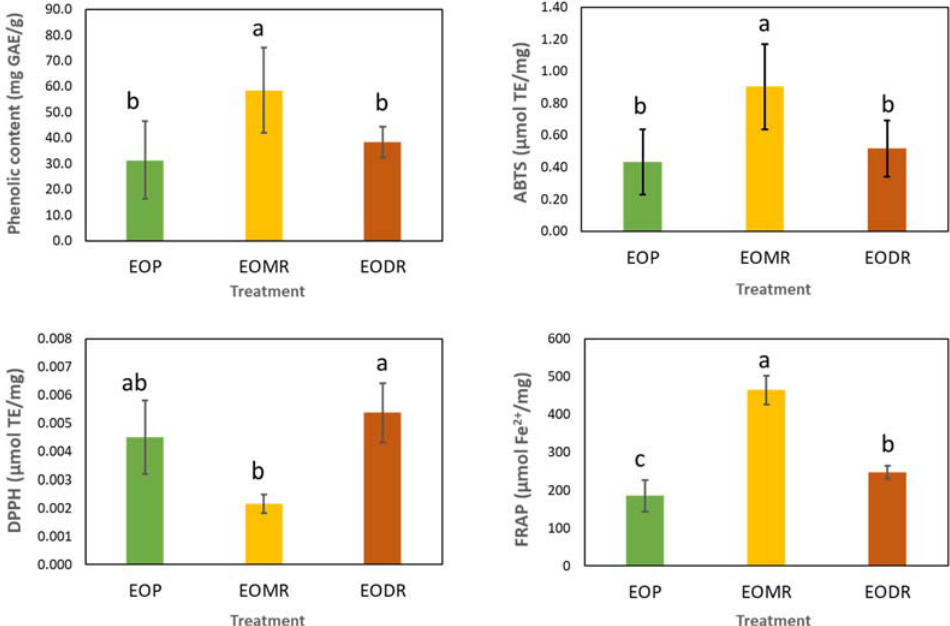
Figure 4. Phenolic content and antioxidant activity [(ABTS and DPPH free radical scavenging and ferric reducing antioxidant power (FRAP)] of essential oils from crude organic propolis (EOP) and from its moist residue (EOMR) and dry residue (EODR). Columns with different letters indicate statistically significant differences ( p < 0.05). Vertical bars represent the standard deviation.